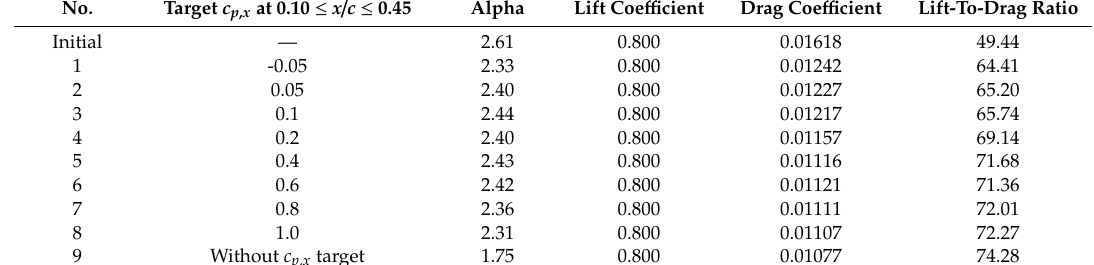
Table 5. Aerodynamic performance of the airfoils with di ff erent pressure gradients ( Ma = 0.73, Re = 6.5 × 10 6 ).